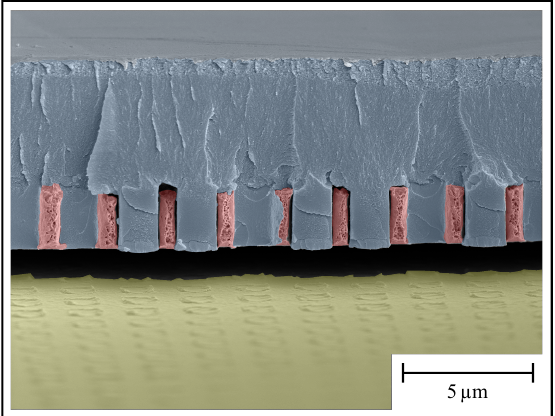
Figure 7. Colorized SEM image of the fixation, side view at an angle of 35 ◦ . The red colored areas show the metallic structure, the blue area shows both the freestanding photoresist pillars as well as the fixation layer, and the yellow area shows the substrate. Please note, during preparation for taking this SEM image (by cleaving to allow a side view) the metallic HWA structure as well as the photoresist is detachted from the